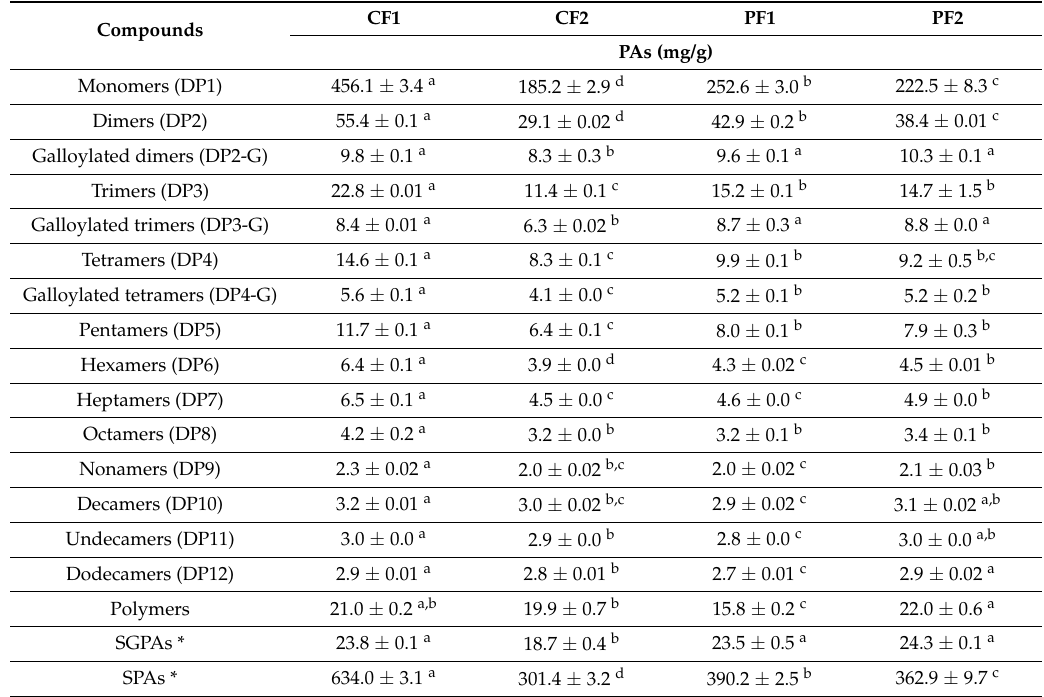
Table 2. Concentrations (mg/g) of flavan-3-ols in grape seeds enriched extracts from cv. Chardonnay (C) and Pignoletto (P) berries. *: SGPAs = Sum of galloylated proanthocyanidins; SPAs = Sum